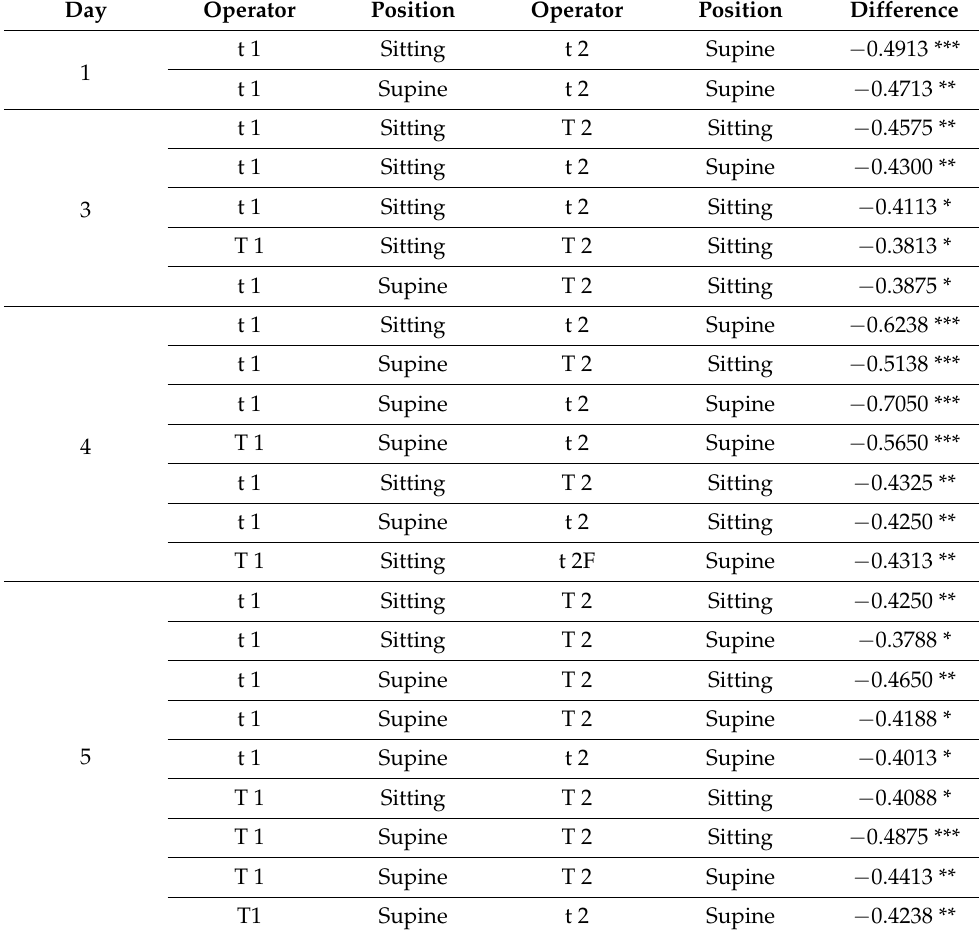
Figure 7. The chamfer width obtained at the reference points by all the participants Friday: ( a ) t1 sitting position; ( b ) t2 sitting position; ( c ) T1 sitting position; ( d ) T2 sitting position; ( e ) t1 supine position; ( f ) t2 supine position; ( g ) T1 supine position; ( h ) and T2 supine position. Table 3. Tukey–Kramer multiple comparison test–extremely significant week are represented in Table 2. Table 2. Mean values of the width of the prepared chamfer.